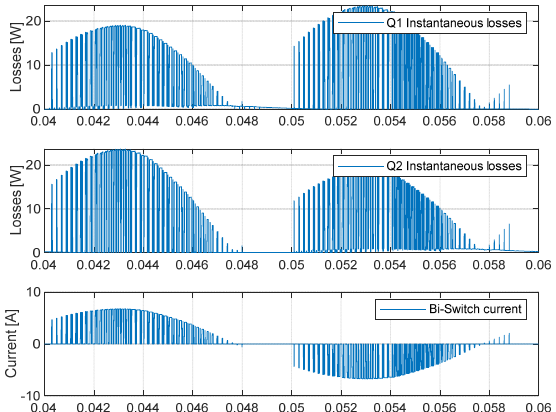
Figure 5. Instantaneous power losses in bidirectional switch.